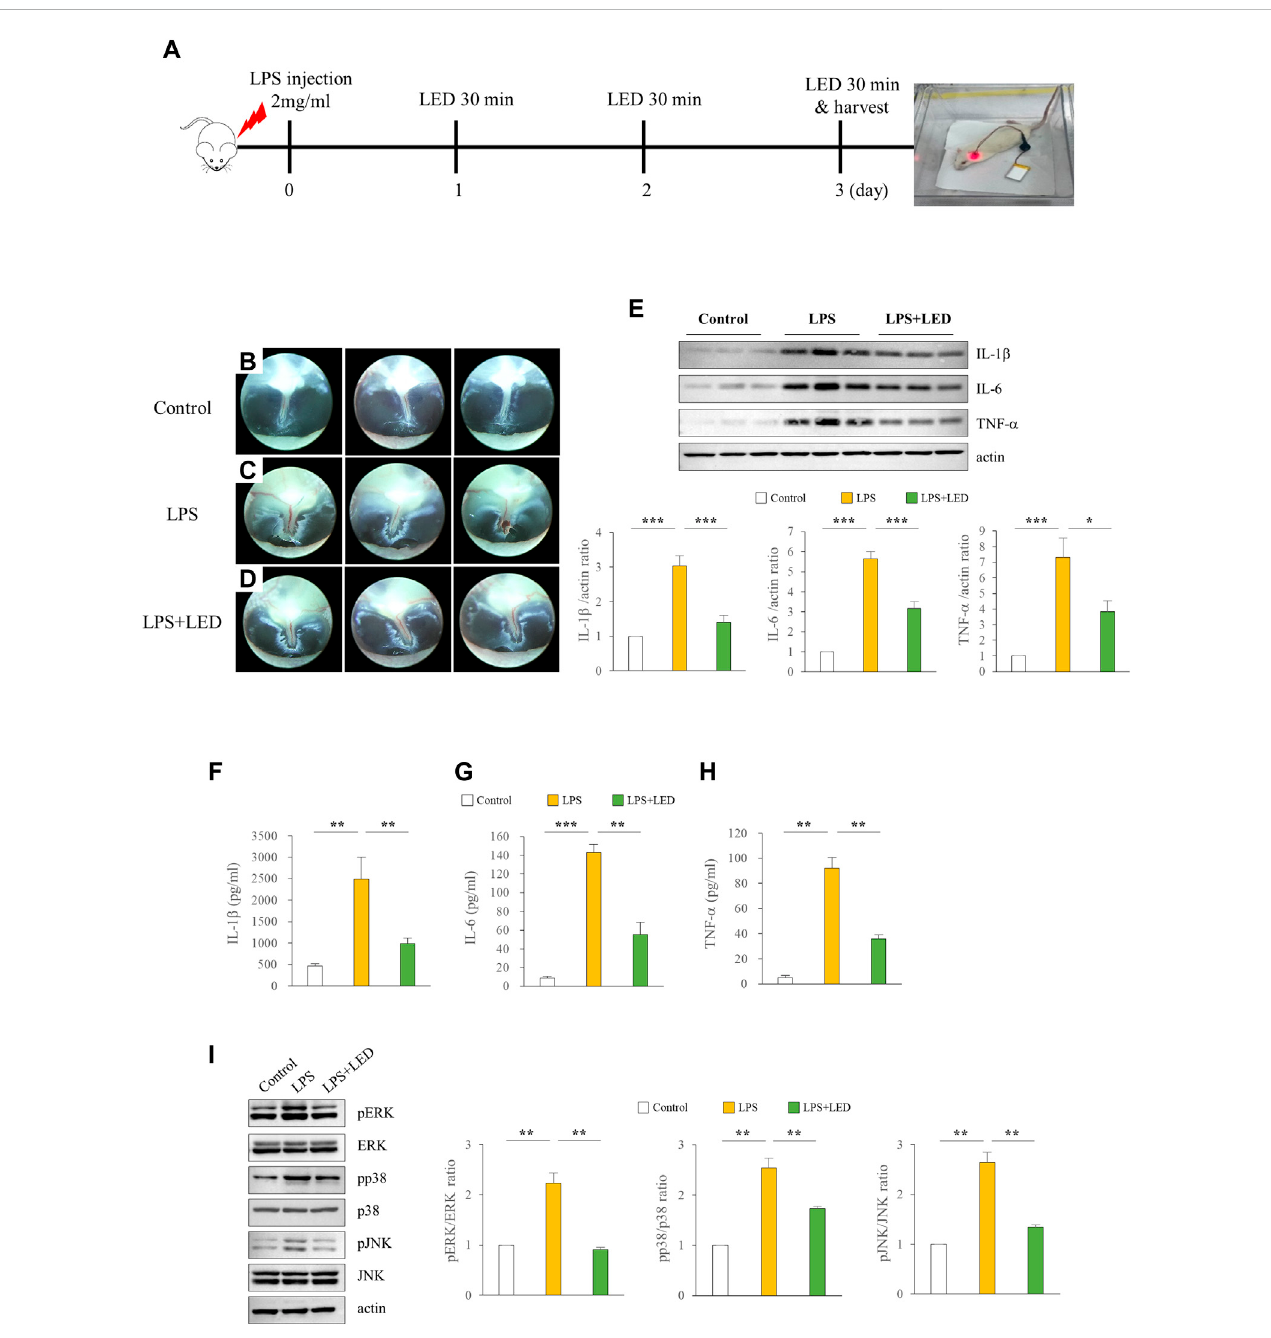
FIGURE 3 AmeliorationofLPS-inducedin fl ammationintheMEofratsbyLEDirradiation via blockadeofMAPKsignaling.LEDirradiationreducedpro-in fl ammatory cytokine release in LPS-induced OM rats. Experimental protocol for LPS exposure in a rat model of OM (50 μ L emulsion of 2 mg/ml LPS) (A) . Representative images of the tympanic membrane of LPS-treated rats with or without LED irradiation (B – D) . Immunoblot analysis of the expression levels of IL-1 β , IL-6, and TNF- α in the tympanic bullae of rats. IL-1 β , IL-6, and TNF- α · protein levels were quanti fi ed following immunoblotting (n = 9) (E) . One-Way Anova: * p < 0.05, ** p < 0.01, and *** p < 0.001. ELISA of pro-in fl ammatory cytokines including IL-1 β (F) , IL-6 (G) , and TNF- α (H) in the tympanic bullae of rats (n = 3). Kruskal Wallis test: ( p ) = 0.001. Reduction of pro-in fl ammatory cytokines in the tympanic bullae of rats by LED irradiation through the blockade of MAPK signaling (n = 6) (I) . Kruskal Wallis test: ( p ) = 0.001. Mann-Whitney U test: * p < 0.05, ** p < 0.01, and *** p < 0.001. Data are expressed as the mean ±